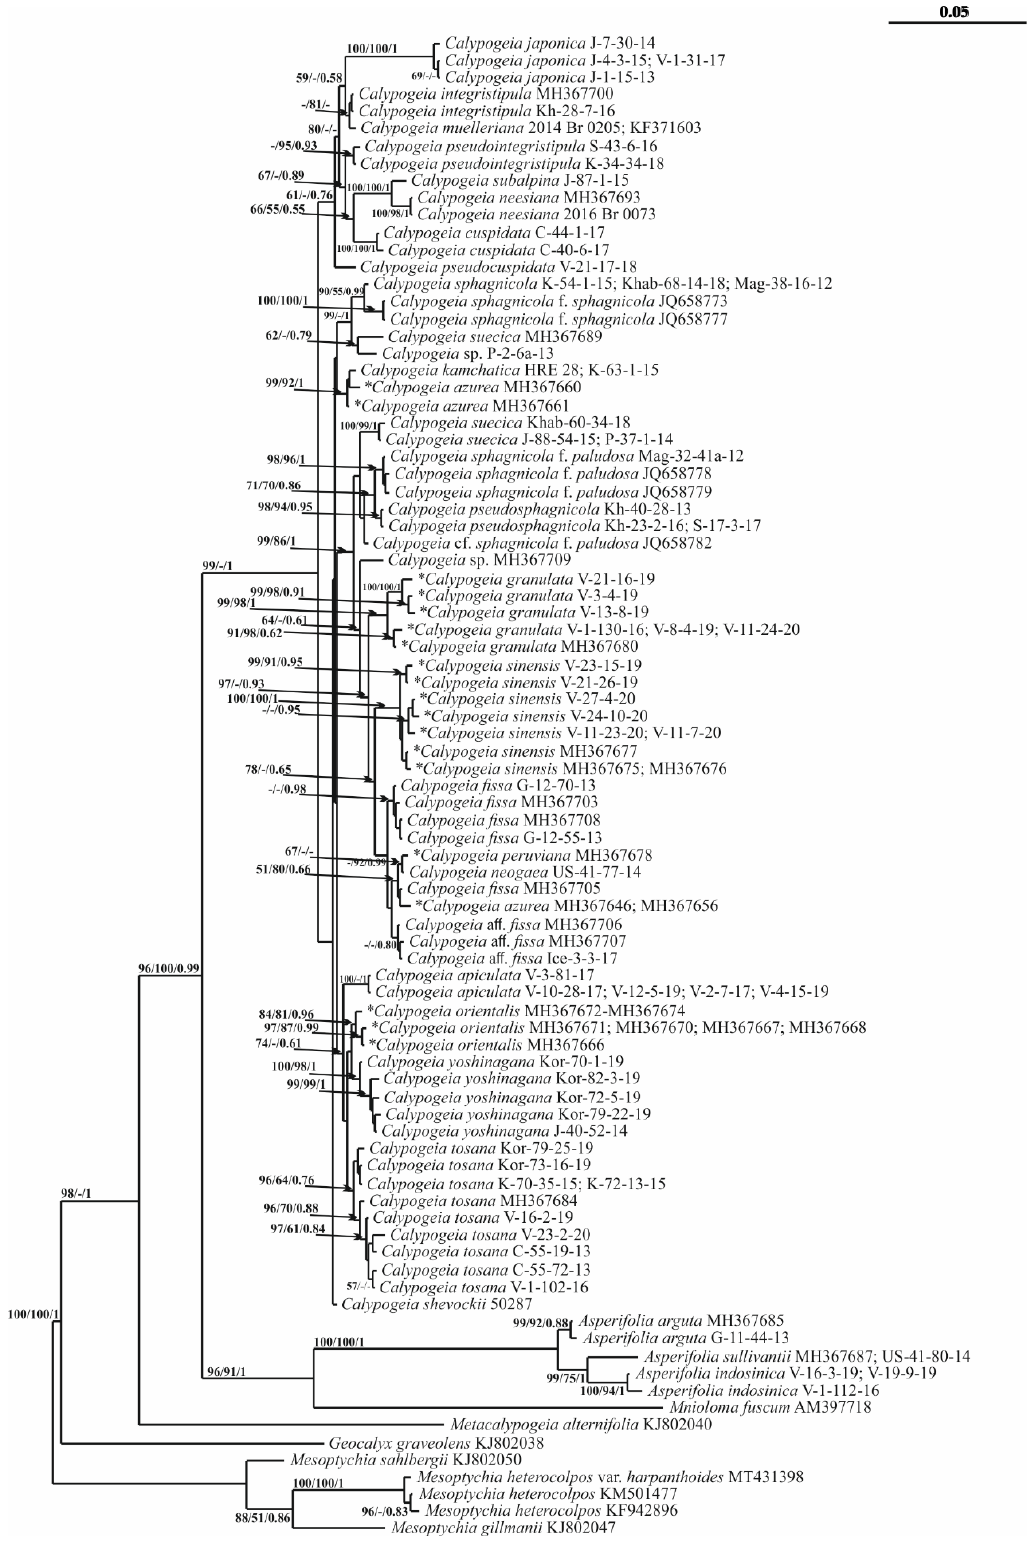
Figure 1. Phylogram obtained in a Bayesian analysis for the genus Calypogeia and related taxa based on trn G-intron. Bootstrap support values > 50% in the MP and ML analyses and Bayesian posterior probabilities > 50% are indicated. Calypogeia species possessing blue oil bodies are marked with an asterisk (*). Scale bar denotes number of nucleotide substitutions per site.